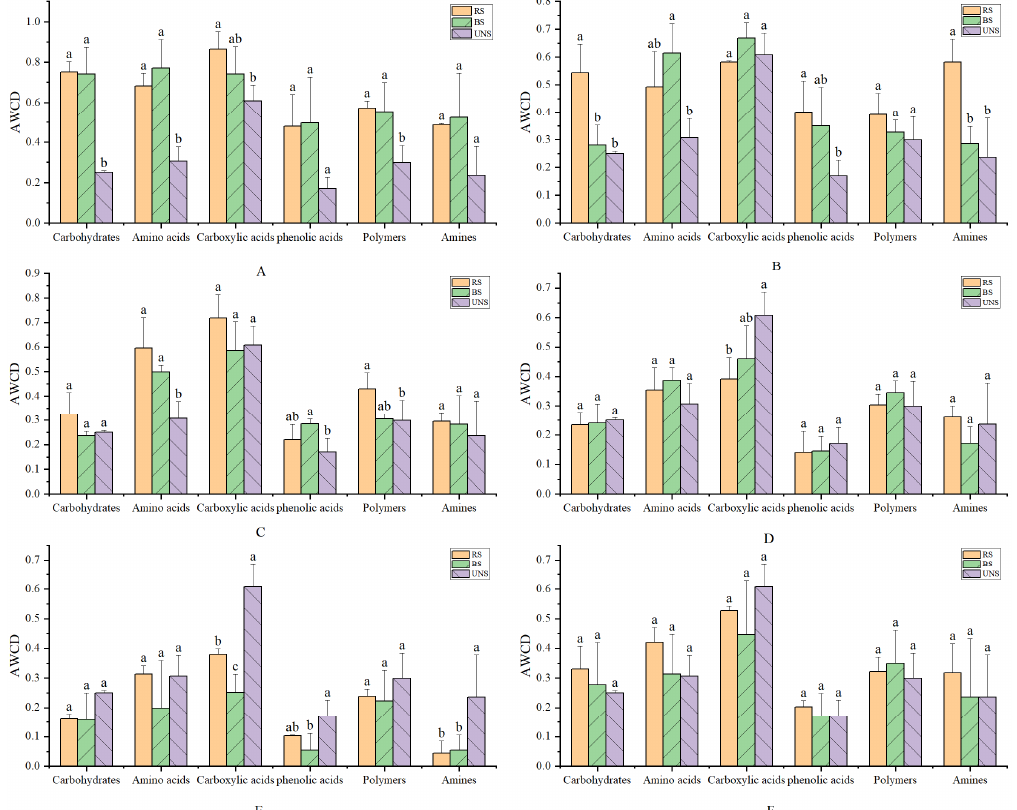
Figure 2. The AWCD values of soil microbial communities were calculated according to the type of carbon sources for comparison of differences in tailing soils under the influence of six native plants and uncontaminated soil. The bars represent the means and SD of 3 replicates. Means not sharing any letter are significantly different at the 5 % level of significance. ( A – F ): C. lanceolata ; Z. schneideriana ; T. ciliata ; C. myrsinifolia ; P. elliottii ; A. cremastogyne ; RS = rhizosphere soil; BS = bulk soil; UNS = uncontaminated soil.